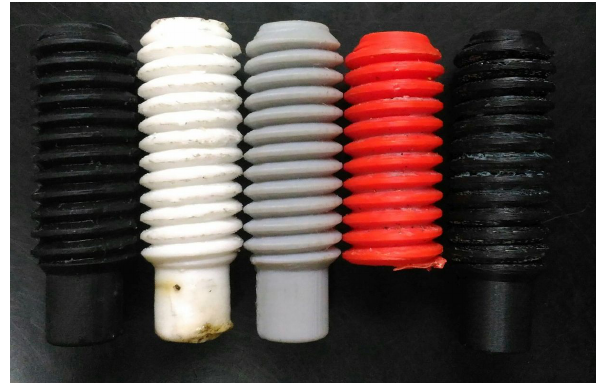
Figure 13: Worm gears printed under different printing settings